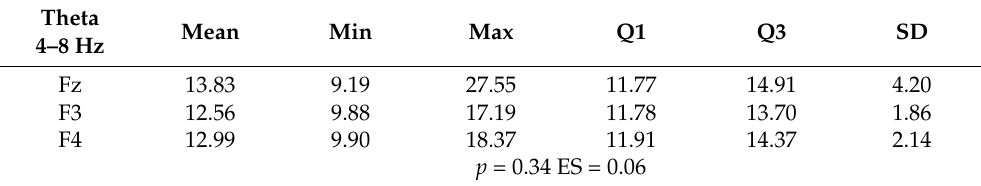
Table 3. Descriptive statistics for Theta waves from all channels ( µ